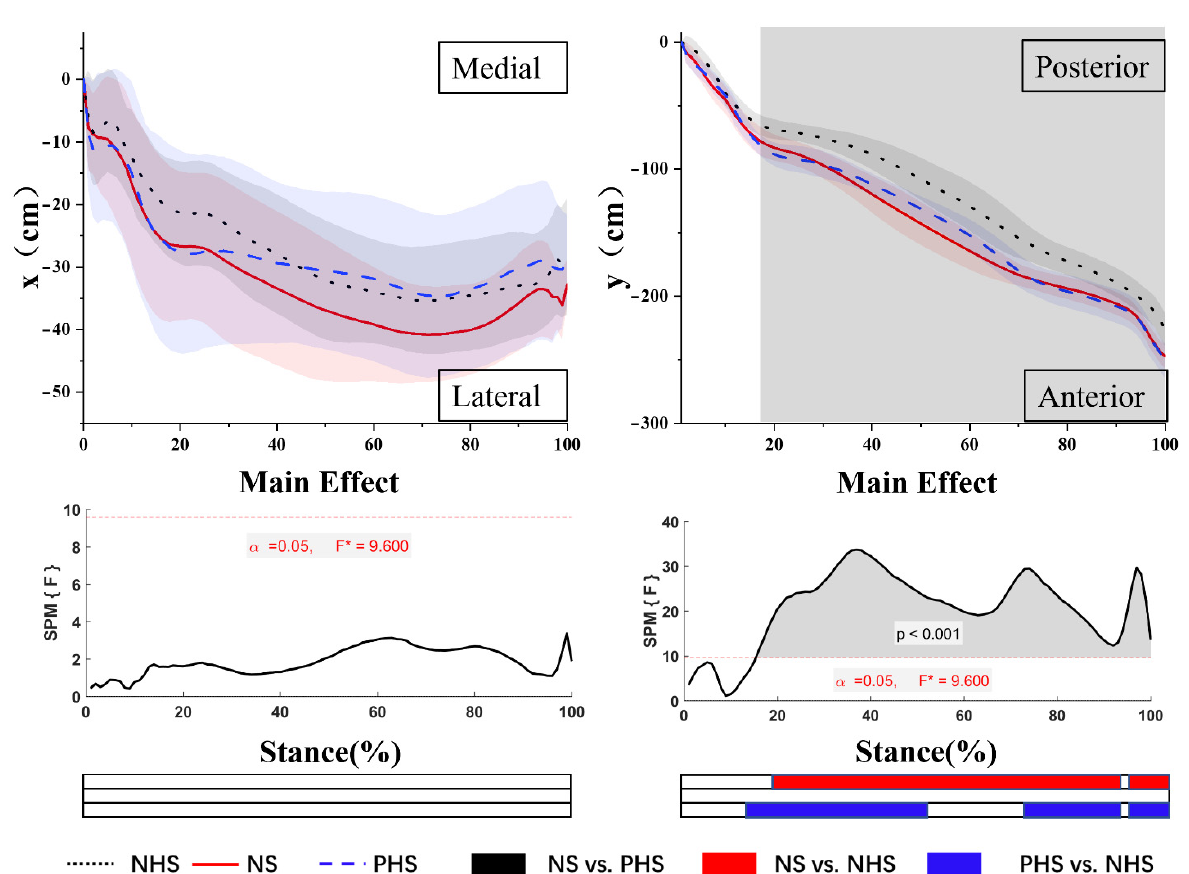
Figure 3. Mean cop trajectories in the x-time and y-time planes. The grey areas indicate significant differences between conditions, followed by the time-dependent F-values of the SPM. Colored bars beneath each plot indicate significant differences between waveforms, whereas the red, blue, and black bars represent significant differences for NS vs. NHS, NHS vs. PHS, and NS vs. PHS, respectively.